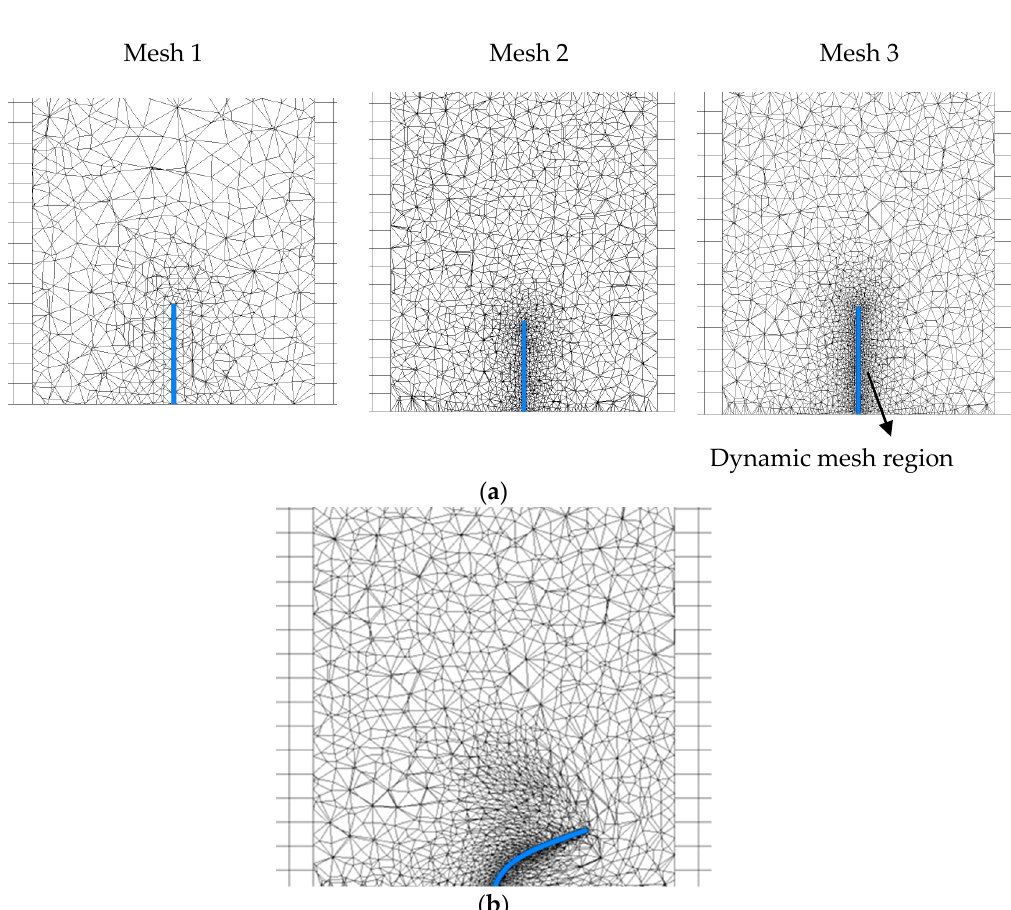
Figure 4. ( a ) Different meshes used in the simulations, with increasing number of elements from left to right at initial time step; ( b ) deformed mesh 3 after 2 sec.